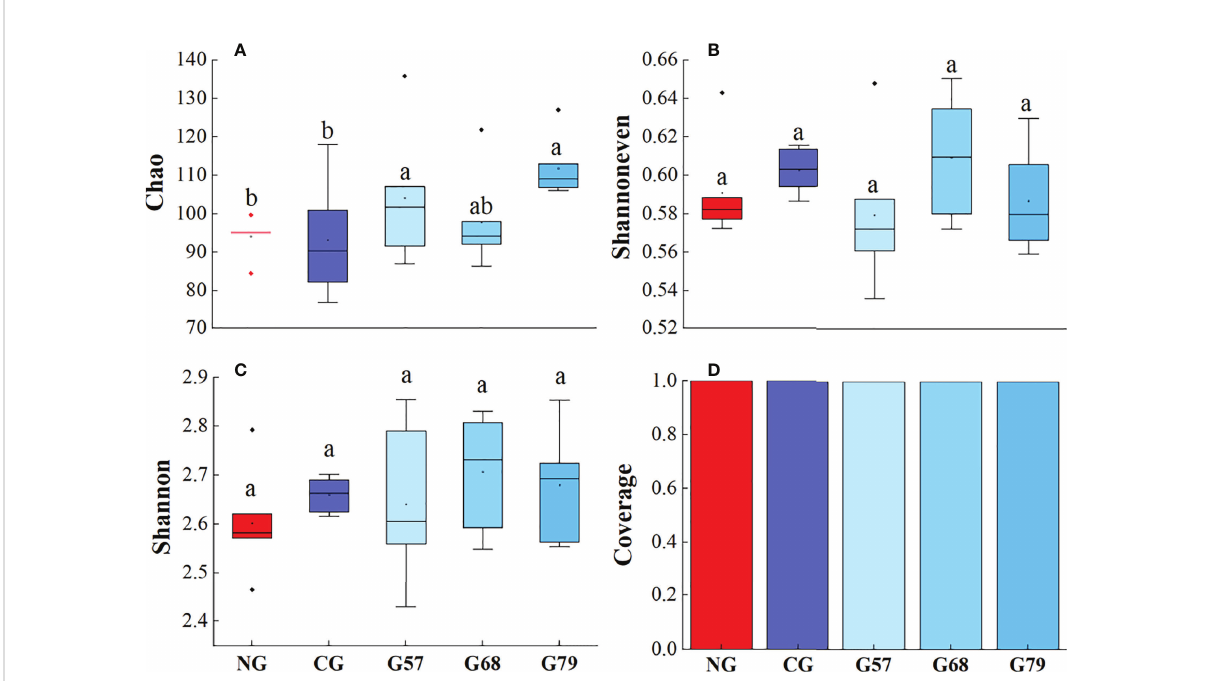
FIGURE 7 Soil archaeal diversity in fi ve grassland management treatments: (A) Chao; (B) Shannoneven; (C) Shannon; (D) Coverage. NG: No grazing; CG: Continuous grazing; G57: Grazing in May and July; G68: Grazing in June and August; G79: Grazing in July and September. The error bars in the fi gure represent the standard error, and the lowercase letters represent the signi fi cant differences ( P